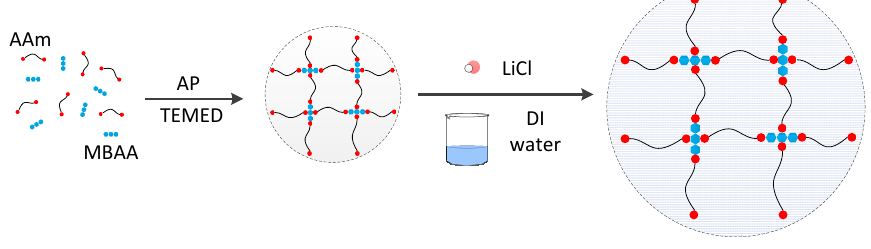
Figure 2. The synthesis of the hydrogel.